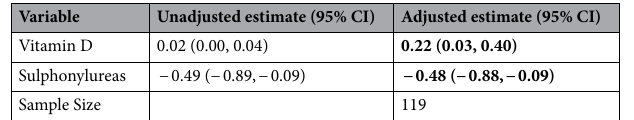
Table 5. Effect of vitamin D on disposition index adjusting for confounding